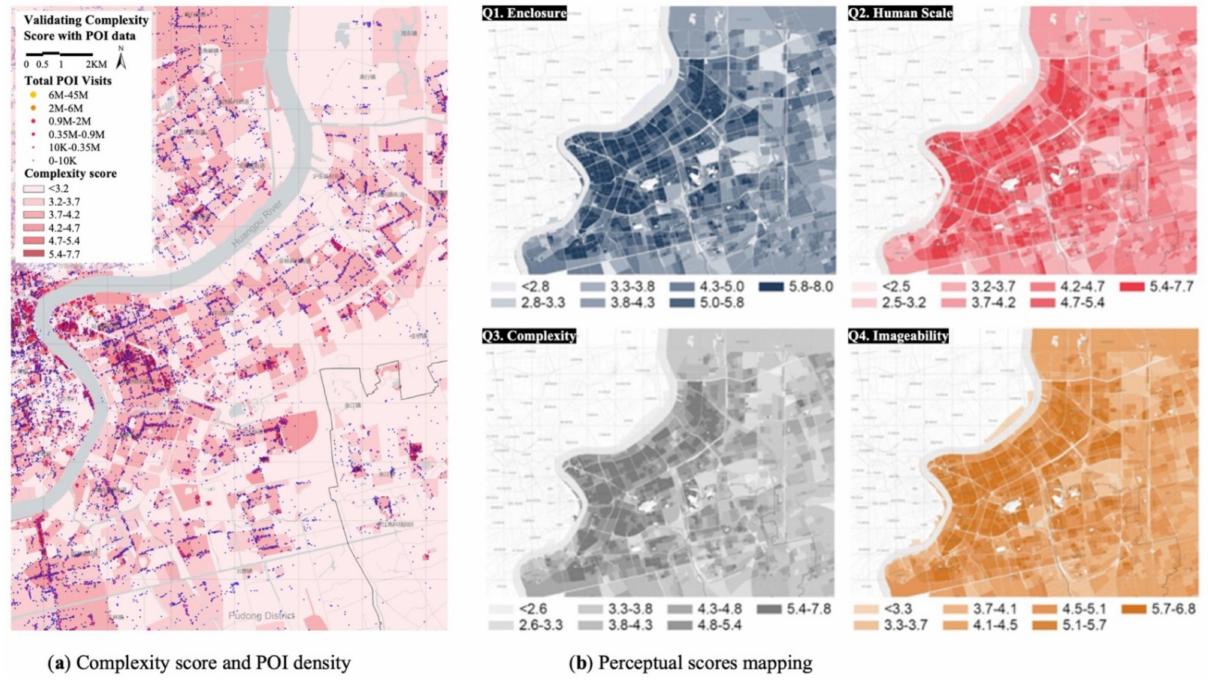
Figure 6. Mapping of ( a ) correlations between complexity score and POI density. ( b ) Cognitive maps of four subjectively predicted perceptual